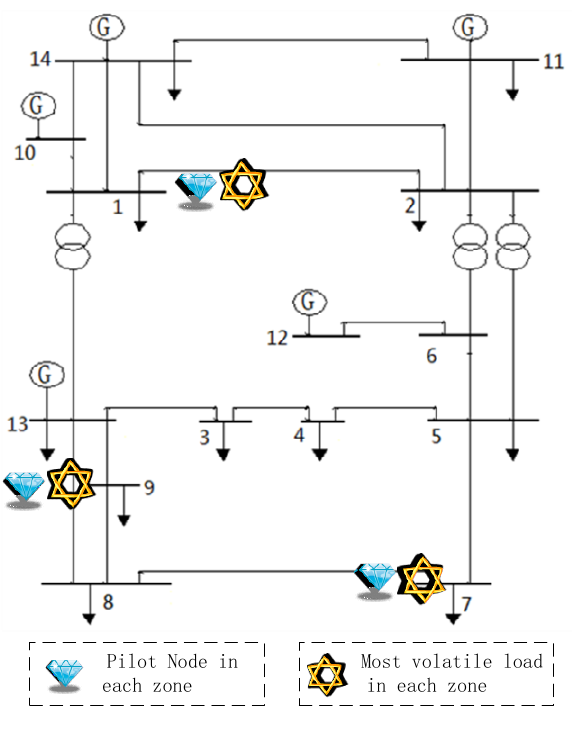
Figure 5. IEEE 14-bus